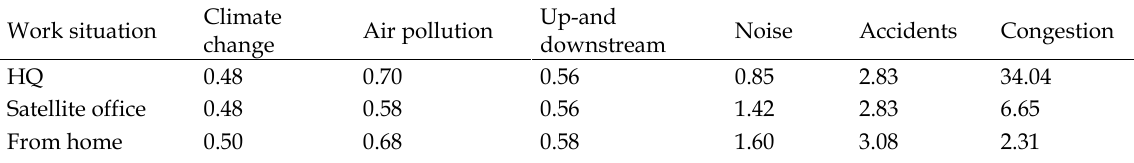
Table 2. Marginal external costs of the various external costs categories for the three situations, expressed in 2011 €ct per vehicle kilometre (MOBI,